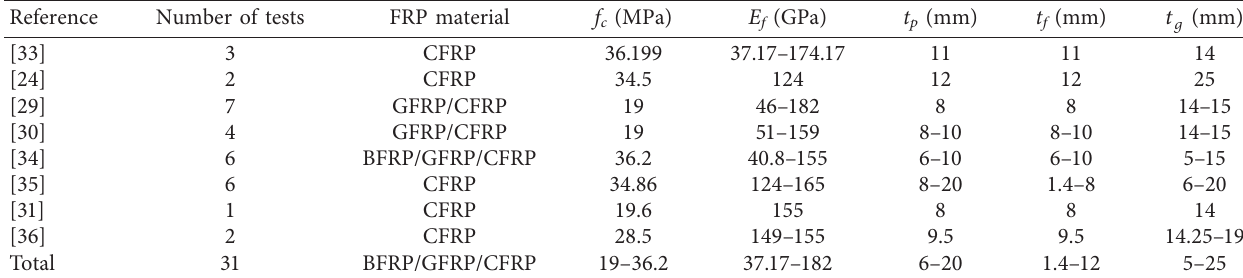
Table 3: Database under the adhesive-FRP interface failure mode.